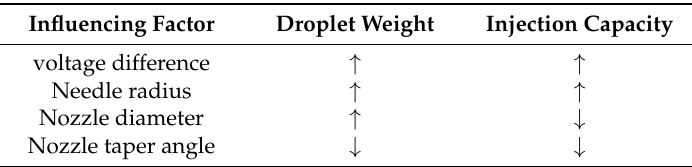
Table 1. Relationship between influencing factors, droplet weight, and injection capacity.